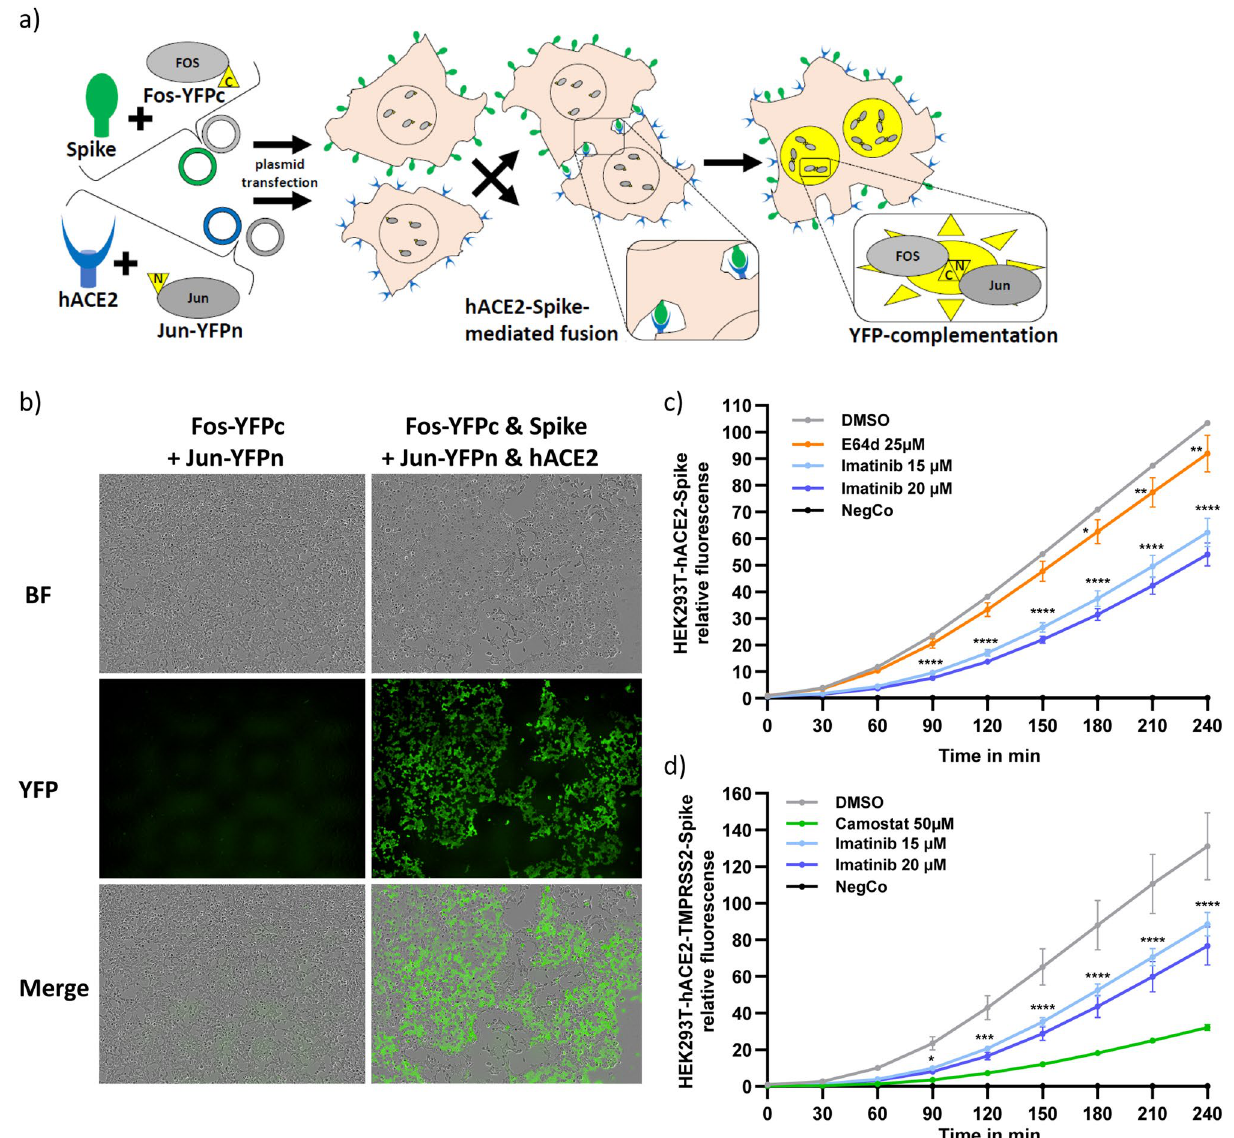
Figure 3. Imatinib delayed Spike mediated syncytia formation. ( a ) Scheme of cell-fusion-assay. HEK293T were transfected with plasmids containing either Fos-YFPc and Spike or Jun-YFPn and hACE2. The transcription factors Fos-YFPc and Jun-YFPn are located inside the nucleus; while hACE2 and Spike are localized at the cell-membrane. When cells mixed together, interaction of hACE2 and Spike lead to cell-fusion. Upon cell fusion Fos-YFPc and Jun-YFPn are heterodimerized and emit fluorescence signals. ( b ) HEK293T cell were transfected with either Fos-YFPc or Jun-YFPn in the presence or absence of hACE2 and Spike. After 2 days, cells were mixed and emitted YFP nuclear signal only in the presence of both hACE2 and Spike. Images represent fusion event 5 h after mixing of the cells. ( c ) Imatinib delayed Spike-hACE2 mediated fusion. HEK293T cells were transfected as done in panel ( b ) and 2 days later were harvested, counted, and treated with the indicated drugs for 2 h. Next, cells were mixed and the plates were immediately transferred in IncuCyte-Incubator. The fluorescens signal was monitored every 30 min and calculated by IncuCyte-software. ( d ) In TMPRSS2-positive cells, imatinib reduced the kinetic of syncytia formation. HEK293T were transfected with either mix of Fos- YFPc and Spike or Jun-YFPn, TMPRSS2 and hACE2. The data in panels ( b ) and ( c ) (N = 2) were analyzed with Two-Way ANOVA with Bonferroni multiple comparison and each represents one of three biological